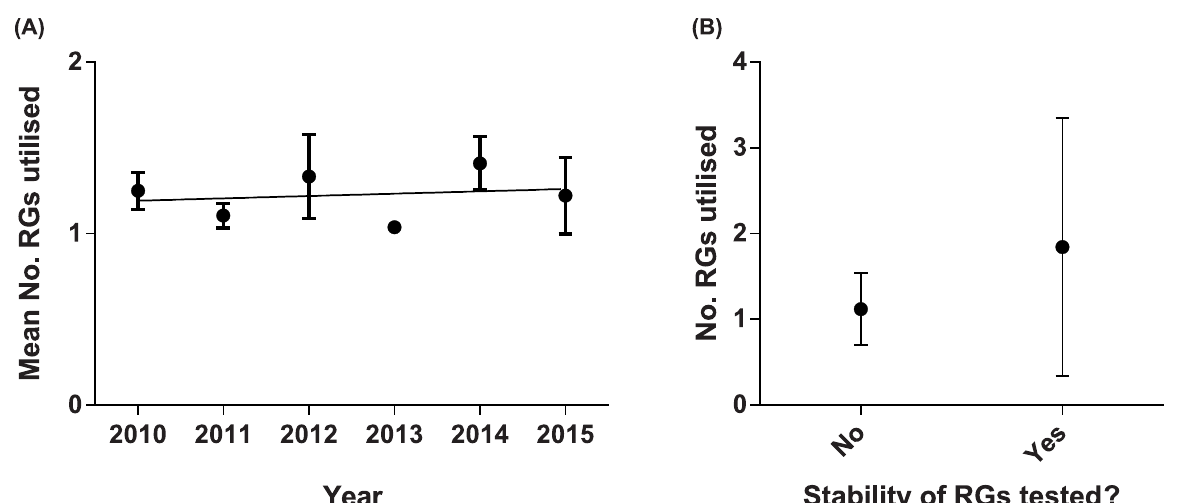
Fig 2. Publication of studies testing expression of GOI(s). Papers included in LitRev1 showing (A) The mean number (no.) of RGs utilised in gene expression studies per year. (B) Mean no. of RGs utilised, according to whether or not a panel of RGs was first tested for stability. In both cases, data is represented as mean (dot) ± standard deviation